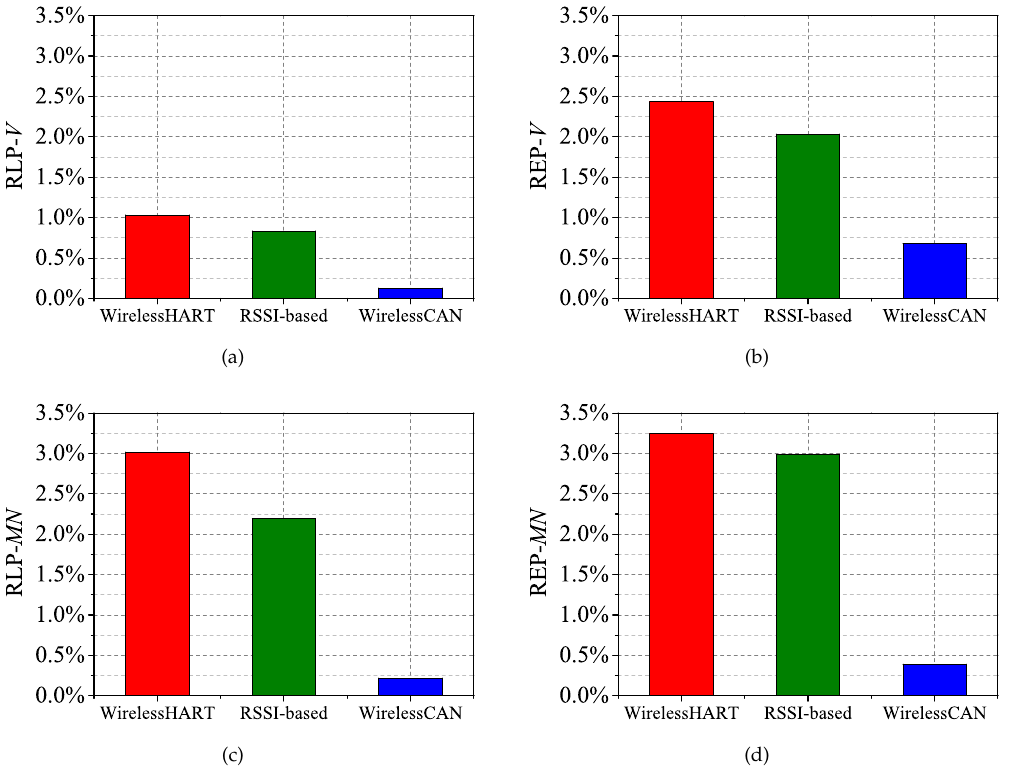
Figure 13. Comparison of RLP- V , REP- V , RLP- MN and REP- MN with a 6% packet error rate. ( a ) RLP- V ; ( b ) REP- V ; ( c ) RLP- MN ; ( d ) REP- MN .